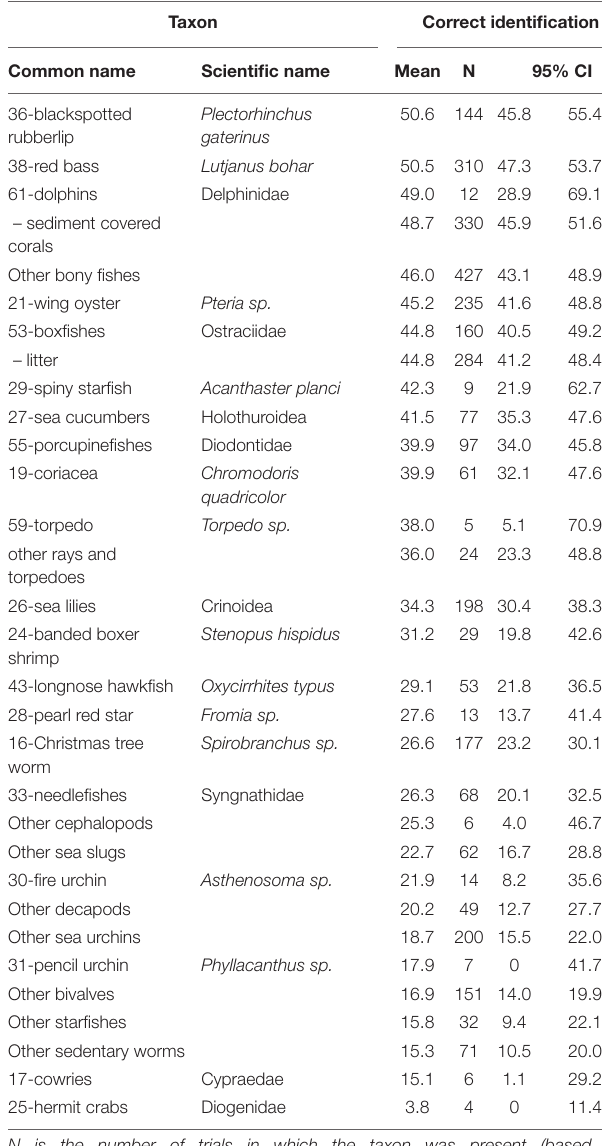
N is the number of trials in which the taxon was present (based on control diver sights).